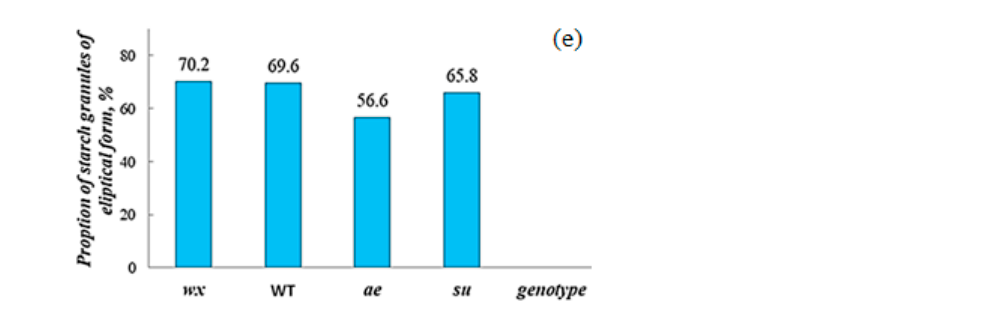
Figure 4. Examples of the granulometric data: diameter ( a ), perimeter ( b ), area ( c ), ellipticity coefficient ( d ), and proportion of elliptical forms ( e ) of starch granules from maize plants of different genotypes.